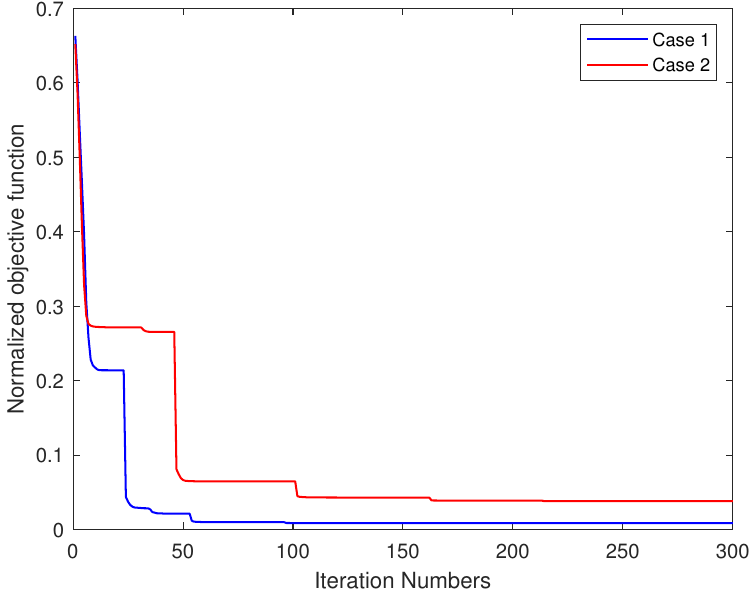
Figure 1. The normalized objective function versus iteration numbers with different desired beam- patterns Case 1 and Case 2.